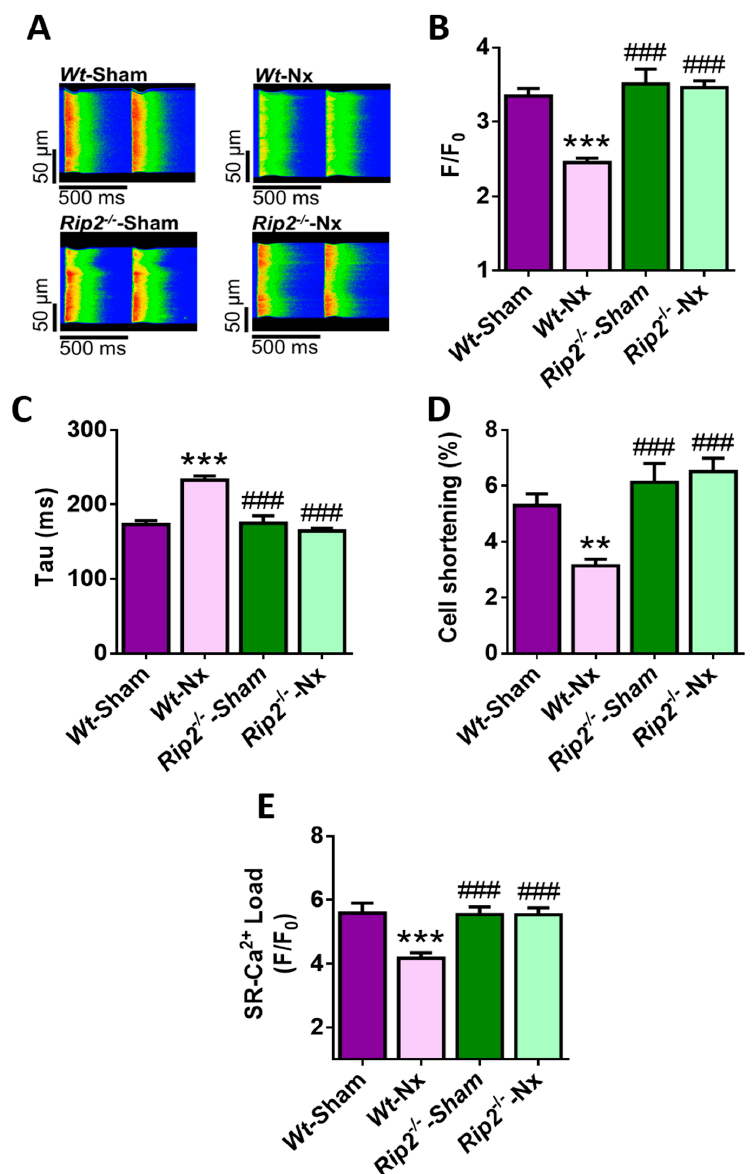
Figure 4. Deficiency of receptor-interacting serine/threonine protein kinase 2 (RIP2) prevents the systolic Ca 2+ mishandling, contractile dysfunction and depressed SR Ca 2+ -load induced by 5/6 nephrectomy. ( A ) Representative line-scan confocal images of Ca 2+ transients obtained from Wt -sham, Wt -Nx, Rip2 − / − -sham and Rip2 − / − -Nx cardiomyocytes electrically evoked under field stimulation at 2 Hz. Mean values of ( B ) peak fluorescence of Ca 2+ transients; ( C ) decay time constant; and ( D ) cell shortening obtained in cells from Wt -sham ( n = 37 cells/four mice), Wt -Nx ( n = 37 cells/four mice), Rip2 − / − -sham ( n = 35 cells/four mice) and Rip2 − / − -Nx ( n = 56 cells/four mice) mice. ( E ) Mean values of caffeine-evoked Ca 2+ transients amplitude obtained in cardiomyocytes from Wt -sham ( n = 29 cells/four mice), Wt -Nx ( n = 32 cells/four mice), Rip2 − / − -sham ( n = 24 cells/four mice) and Rip2 − / − -Nx ( n = 36 cells/four mice) mice. Results show mean ± SEM. ** p < 0.01; *** p < 0.001 vs. Wt -sham; ### p < 0.001 vs. Wt -Nx.